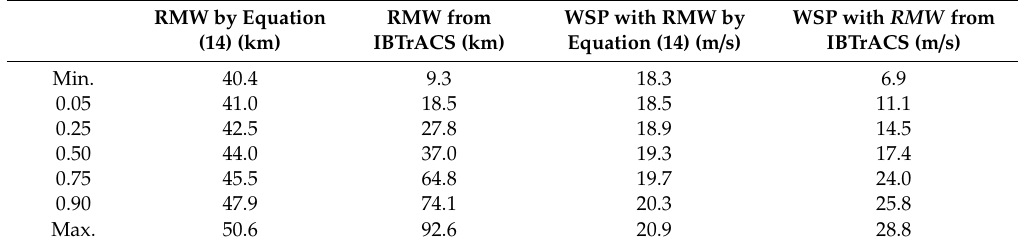
Table 2. Variables to run modified H10 (MH10).